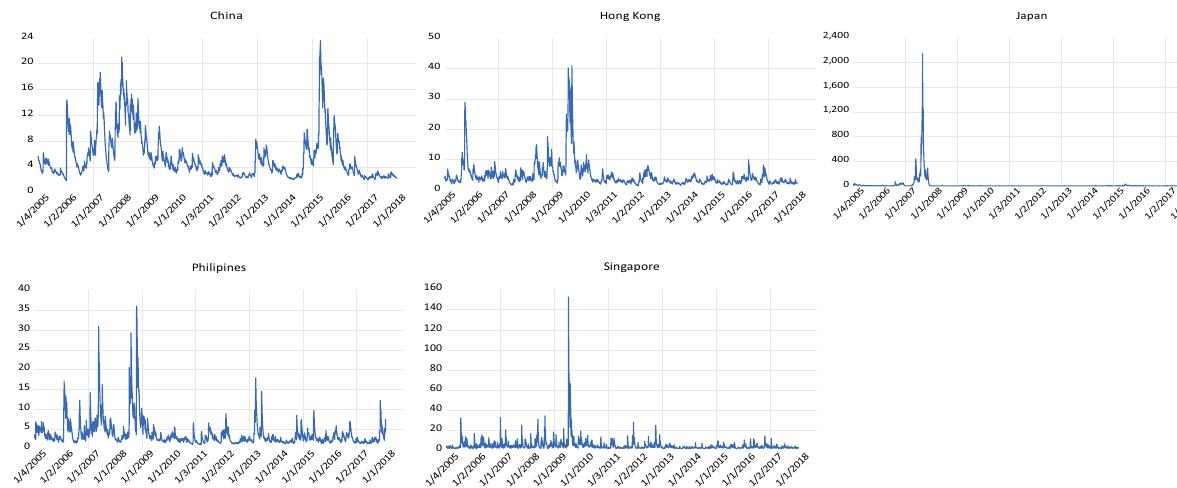
Fig. 5 Time-varying correlations of individual country Water Index Returns based on DCC-GARCH model.